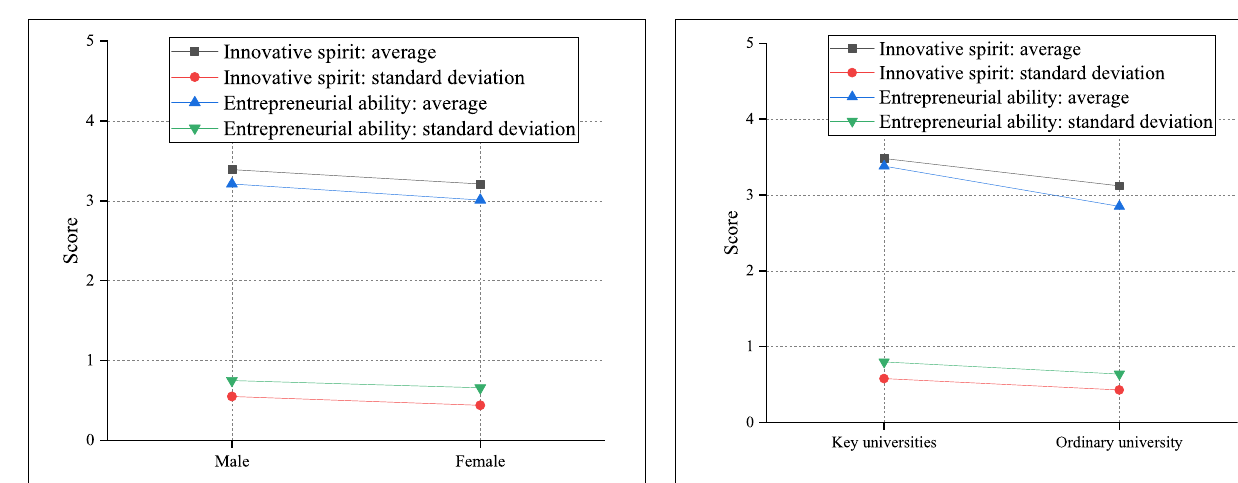
FIGURE 10 | An analysis of the impact of college differences on the innovation and entrepreneurship